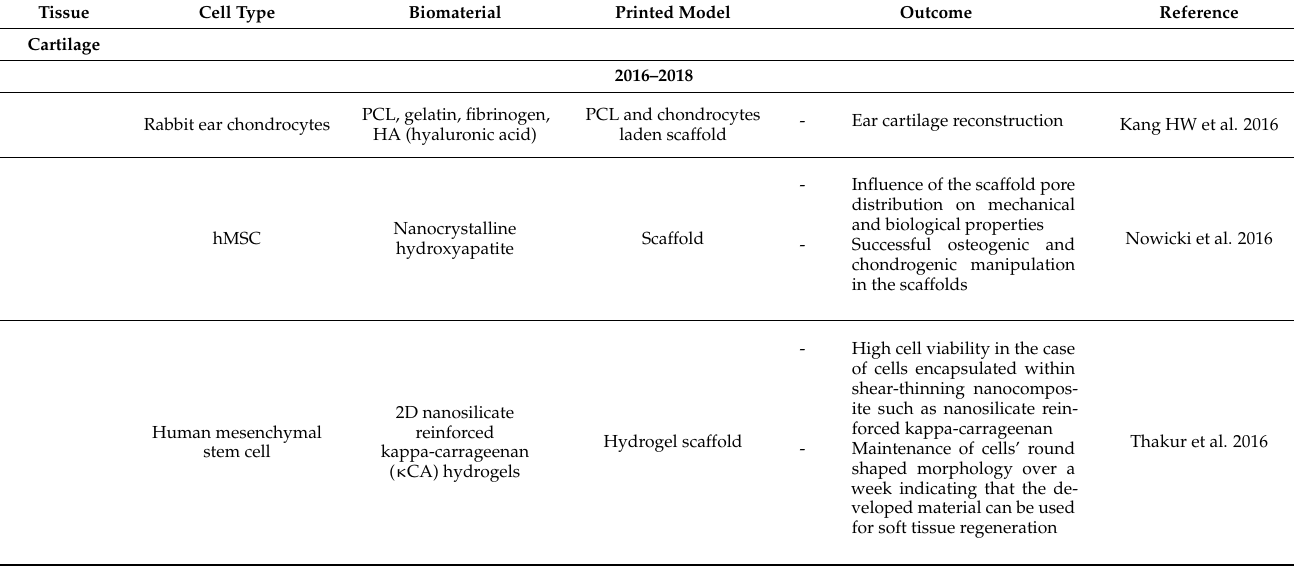
Table 4. Remarkable achievements in 3D bioprinting of cartilage tissue. Articles from 2016 to 2018 and from 2019 to 2020.